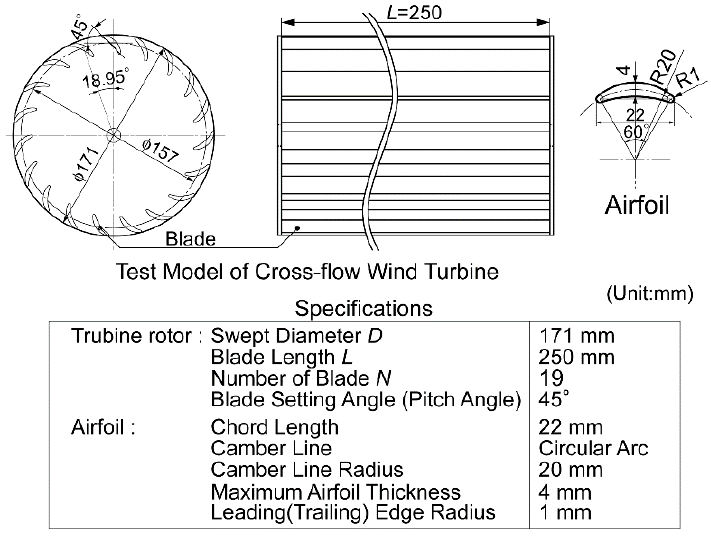
Figure 2. Cross-flow wind turbine test model and airfoil.